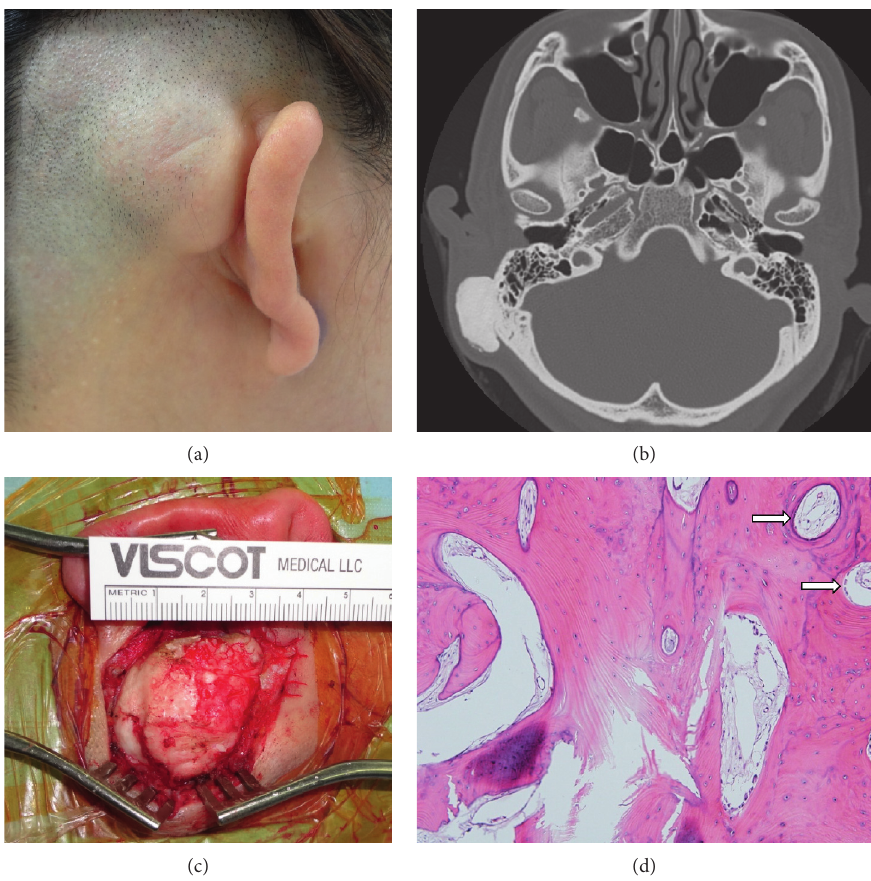
Figure 2: Right postauricular bulging mass which is asymptomatic, hard, and non-movable (a). Temporal bone computed tomography shows a huge, well-demarcated, and bony mass on the right mastoid cortex (b). The intraoperative view of a large bony tumor after elevation of the periosteum (c). The microscopic finding showing areas composed primarily of compact, mature, lamellar bone with organized Harvesian canals (d) (arrows, H&E ×